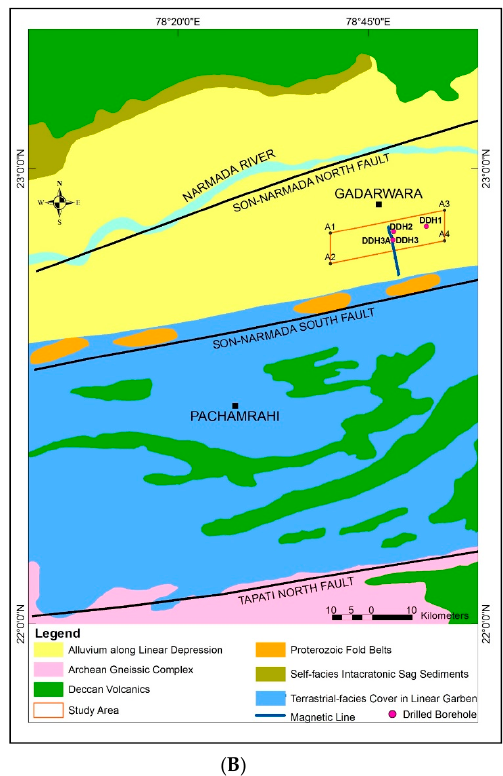
Figure 2. ( A ): ( a ) Simplified Tectonic Map of India; ( b ) Simplified geological Map of the Central Indian Tectonic Zone in central India, showing all the supracrustal belts and tectonic lineaments (modified after Yedekar et al. 1990 [24], Acharyya and Roy 2000 [25], Chattopadhyay and Khasdeo 2011 [26]; ( c ) Geological Map of Study area (after Sunder Raju., 2014 [27]. ( B ) Geological Map of the Study area.